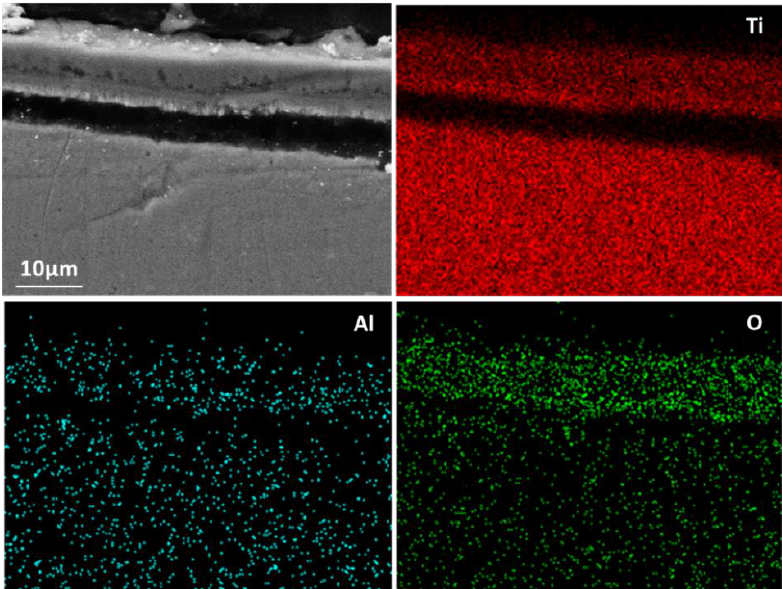
Figure 3. Scanning electron microscopy (SEM) image and energy dispersive spectrometer (EDS) mapping for cross-sectioned Ti heated up to 800 °C.